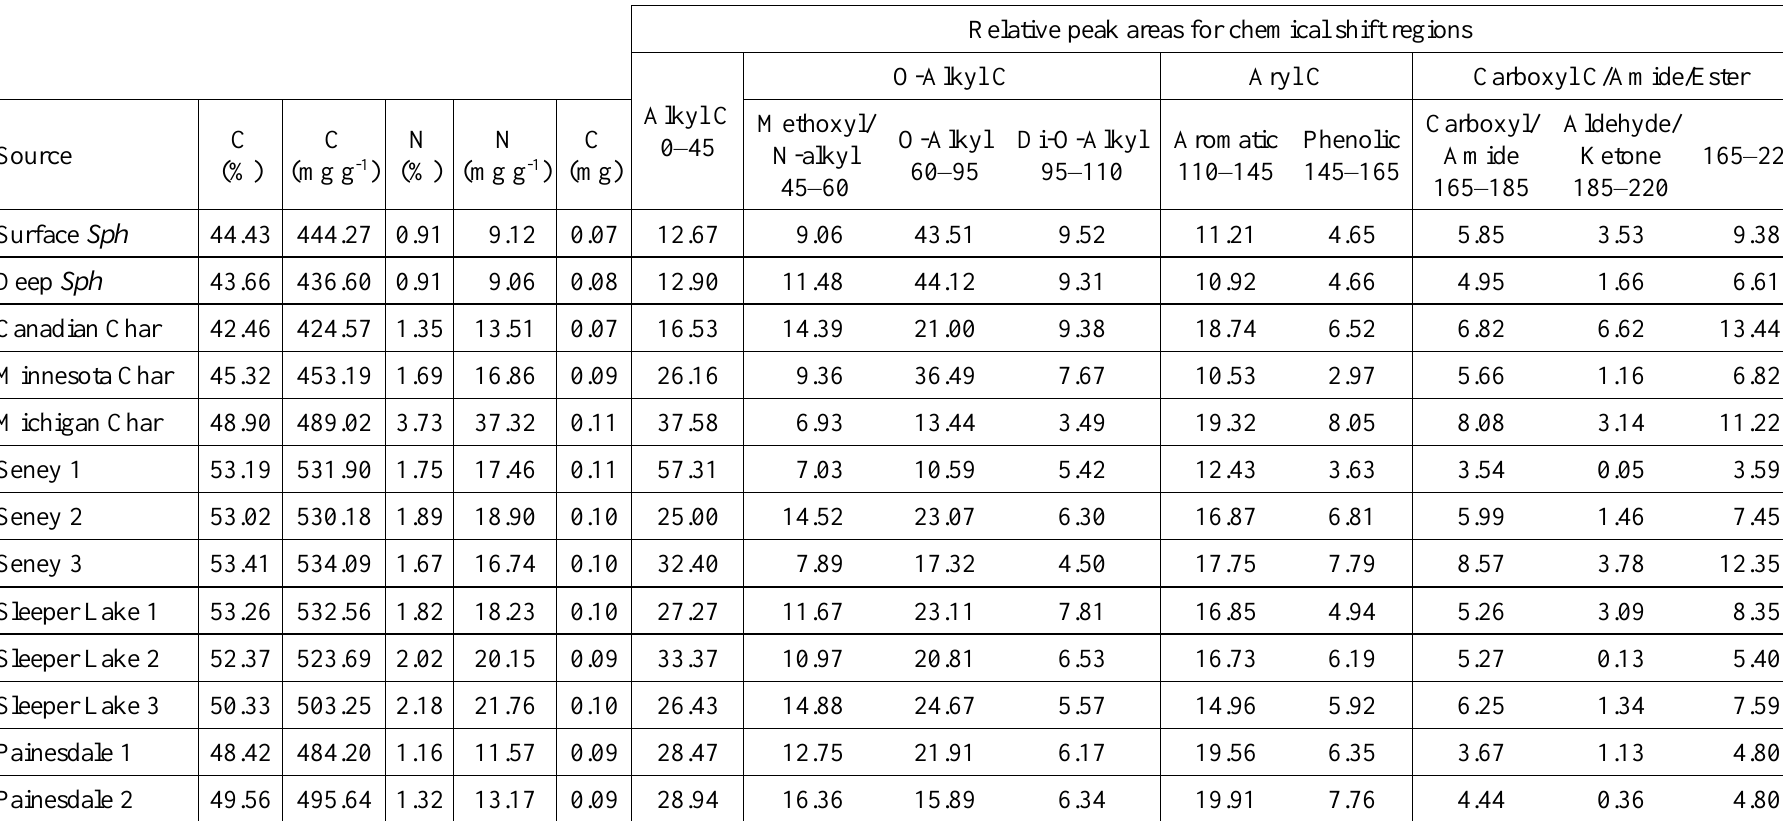
Table A4. Elaboration upon Table A2, providing additional data on cross polarisation NMR chemical shift regions, and on C and N concentrations. Relative peak areas for chemical shift